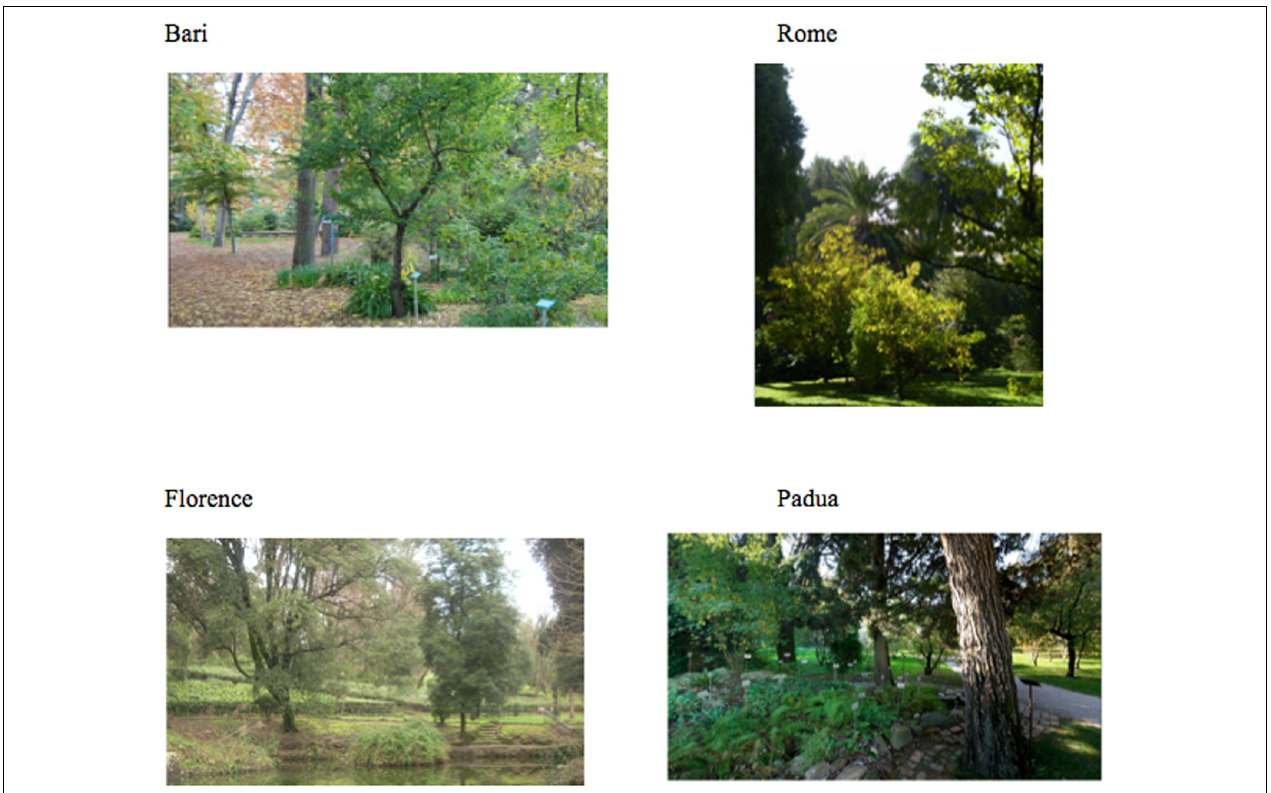
FIGURE 1 | Sample images of the selected botanical gardens in Bari, Rome, Florence, and